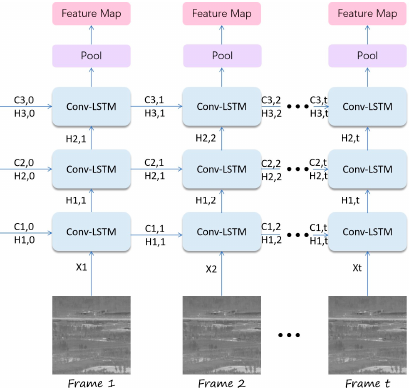
Figure 7. The workflow of STM in the proposed model. The STM has 3 Conv-LSTM layers followed by 1 pooling layer. It takes multiple frames as inputs, such as t frames. t is related to the targeted motion speed. We set t to 5 in this paper.